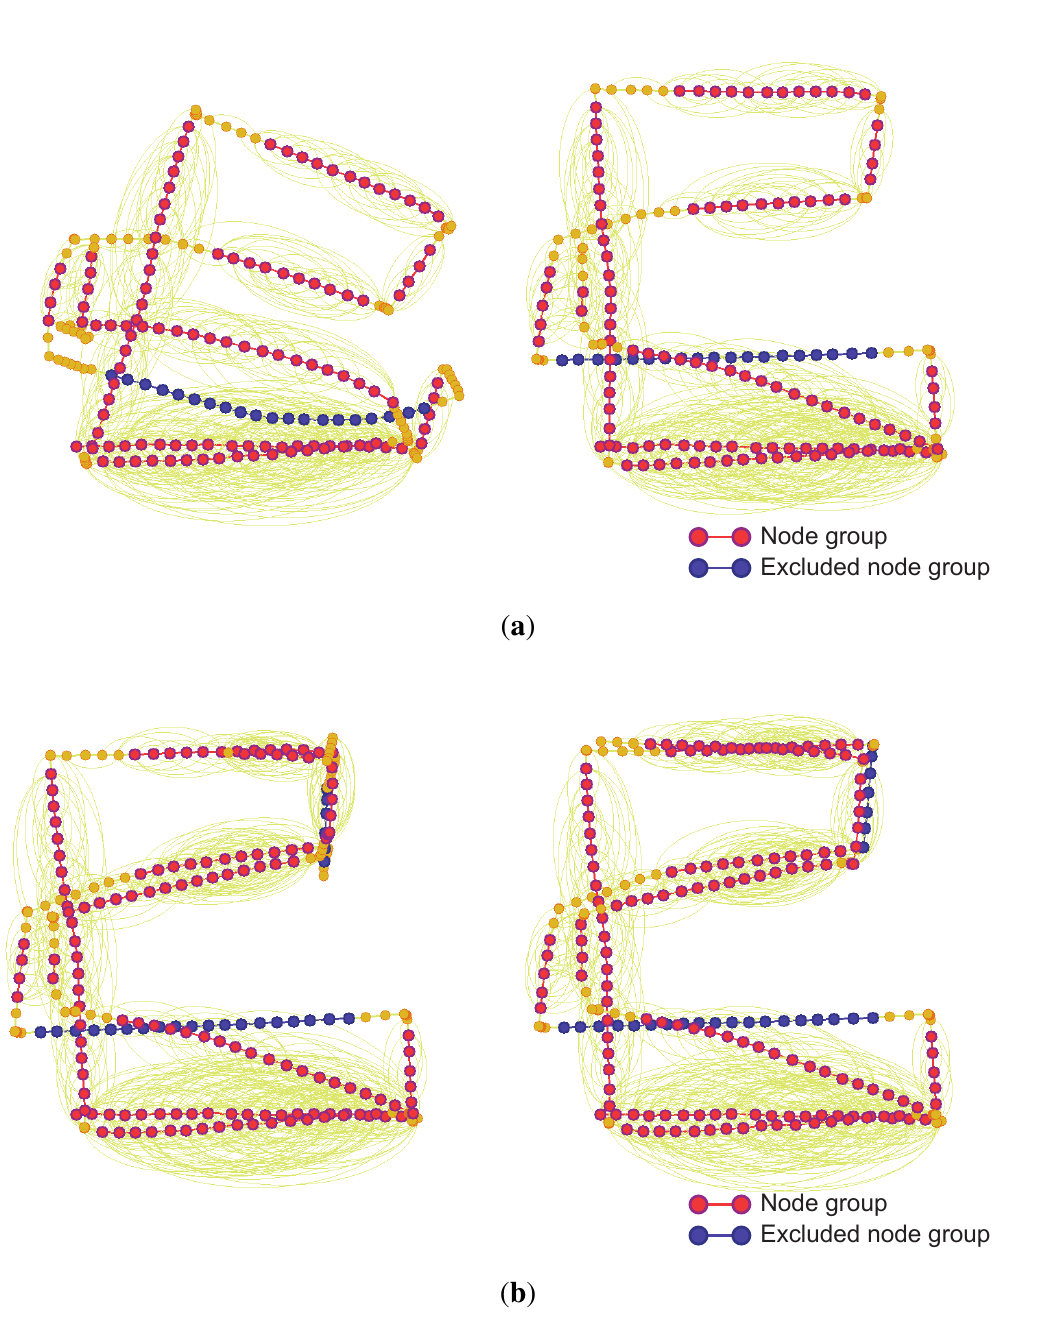
Figure 21. Left: At the moment of movement detection in low dynamic environments. Right: Reoptimized graph structures after excluding false constraints. ( a ) By object 1 in experiment 3; ( b ) By object 2 in experiment